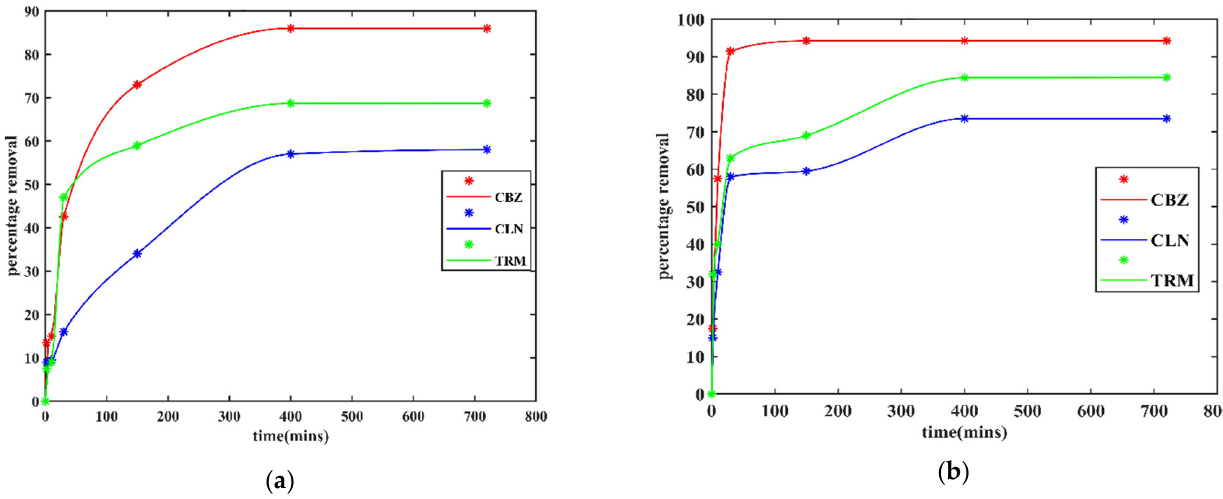
Figure 4. Percentage removal rates of APIs with time from ( a ) effluent and ( b ) Milli-Q water.